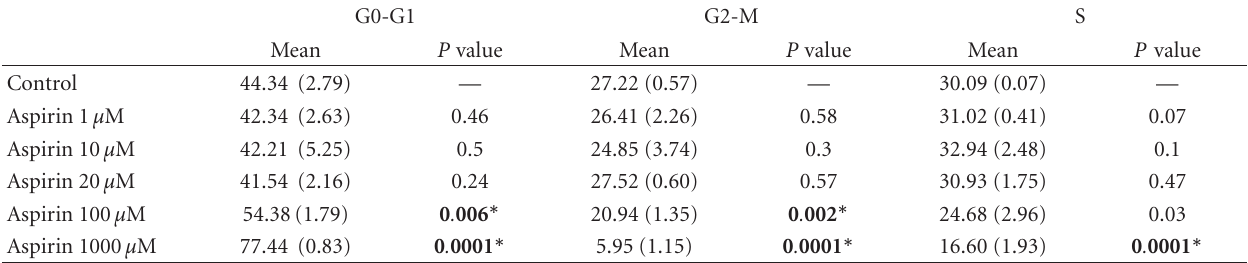
Table 1: Numerical data for cell cycle fluorescence profile of MG-63 cells in culture treated for 24 h with aspirin doses of 1, 10, 20, 100, or 1000 μ M.